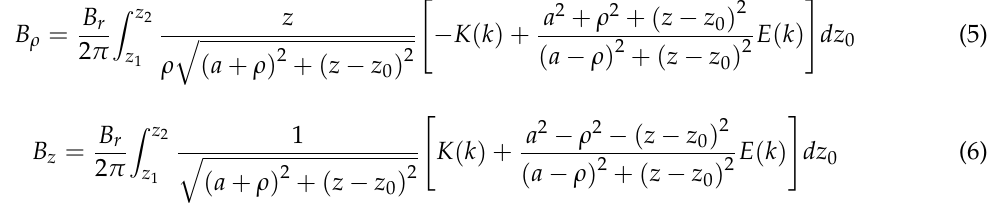
Figure 4. Magnitude of the magnetic field as a function of depth over the center of magnets. 2.3. RF Coil Design To excite hydrogen and receive as many signals as possible in the ROI, three arc spiral coils of the same size connected in series (Figure 5) were used as the RF coil. Based on reference [15], when the experimental environment and the B 0 remained the same, the SNR was proportional to the B 1 generated by the RF coil and inversely proportional to the current through the RF coil and the square root of the AC resistance of the coil, as in Equation (7). 1